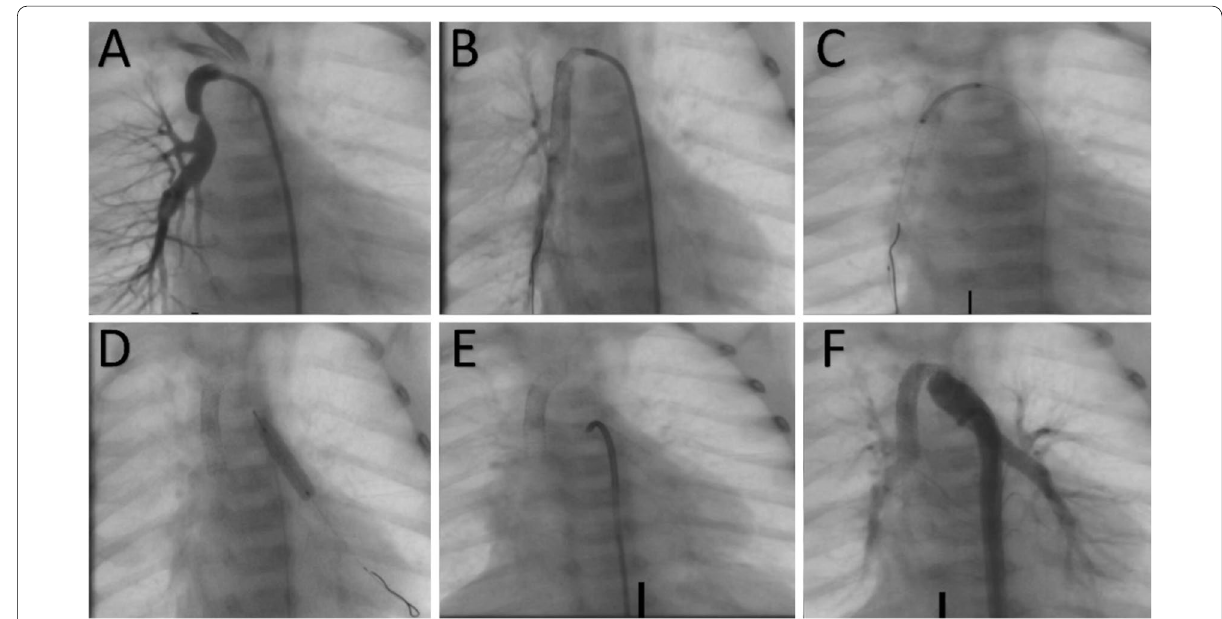
Fig. 2 Stenting of double patent ductus arteriosus (PDA) in a patient with tetralogy of Fallot/pulmonary atresia and disconnected pulmonary arteries. The right pulmonary artery is supplied by a PDA from the subclavian artery that was stented with 2 stents (upper panel images, A – C ). The left pulmonary artery is supplied by a PDA from the proximal descending aorta that was stented with one stent (lower panel images, D – F )